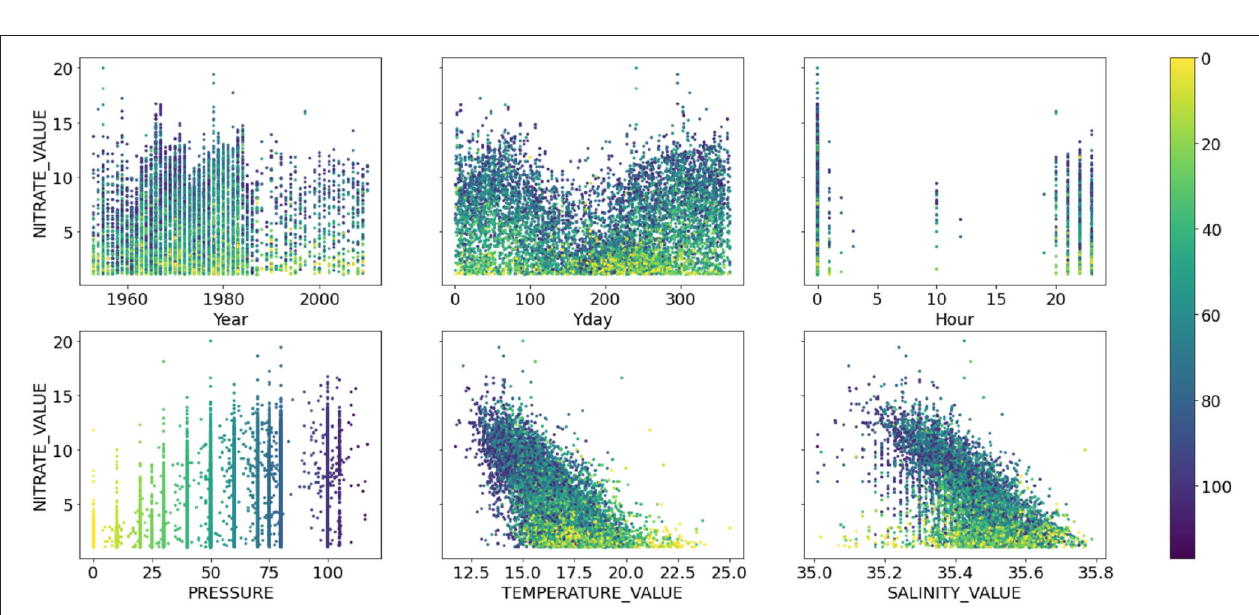
FIGURE 2 | Same as Figure 1 but showing the scatter plots of nitrate concentration ( µ moll − 1 ) against the six